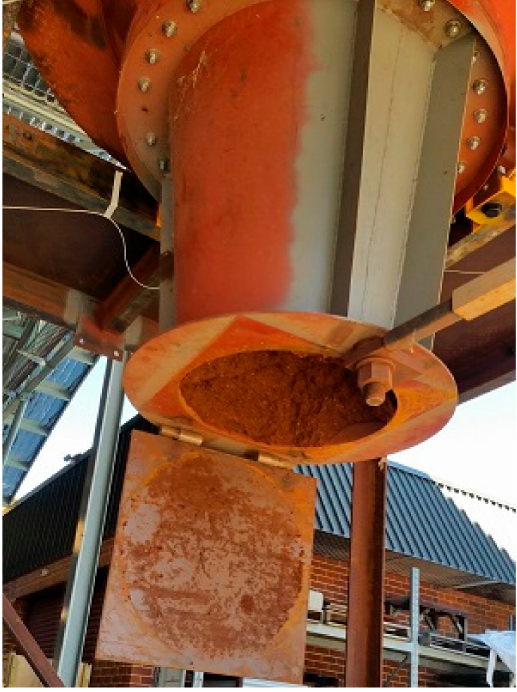
Figure 4. Procedure to evaluate Equation (1).